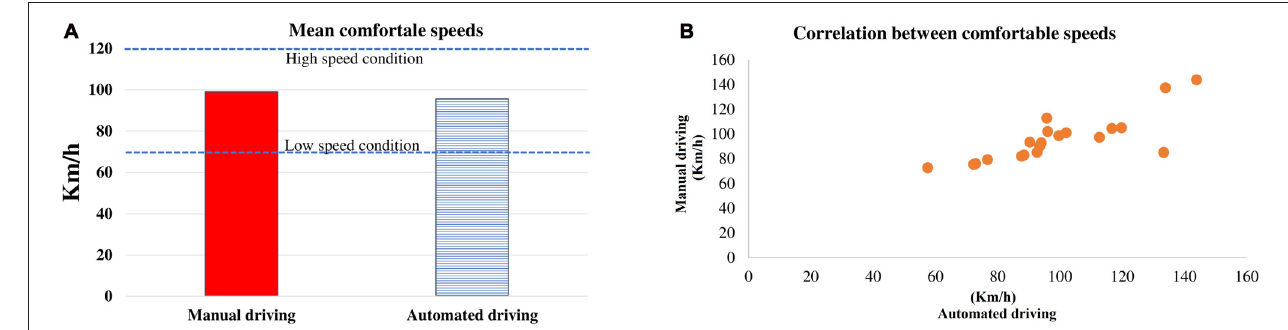
FIGURE 3 | Mean (and standard error, SE) comfortable speeds selected in the manual and automated driving conditions (A) . Blue lines indicate the speeds required in the high speed conditions and low speed conditions. On the right side (B) , a scatter plot is presented with the mean comfortable speeds per participant in the manual and automated conditions.